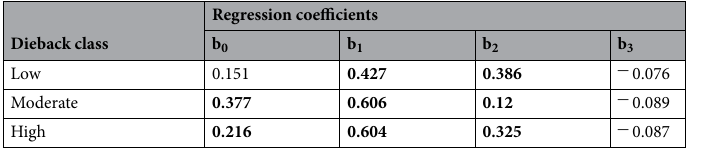
Table 1. Regression coefficients for three dieback categories during 1994–2018 from the multiple linear regression model (1). Regression coefficients significant at 5% level are marked in